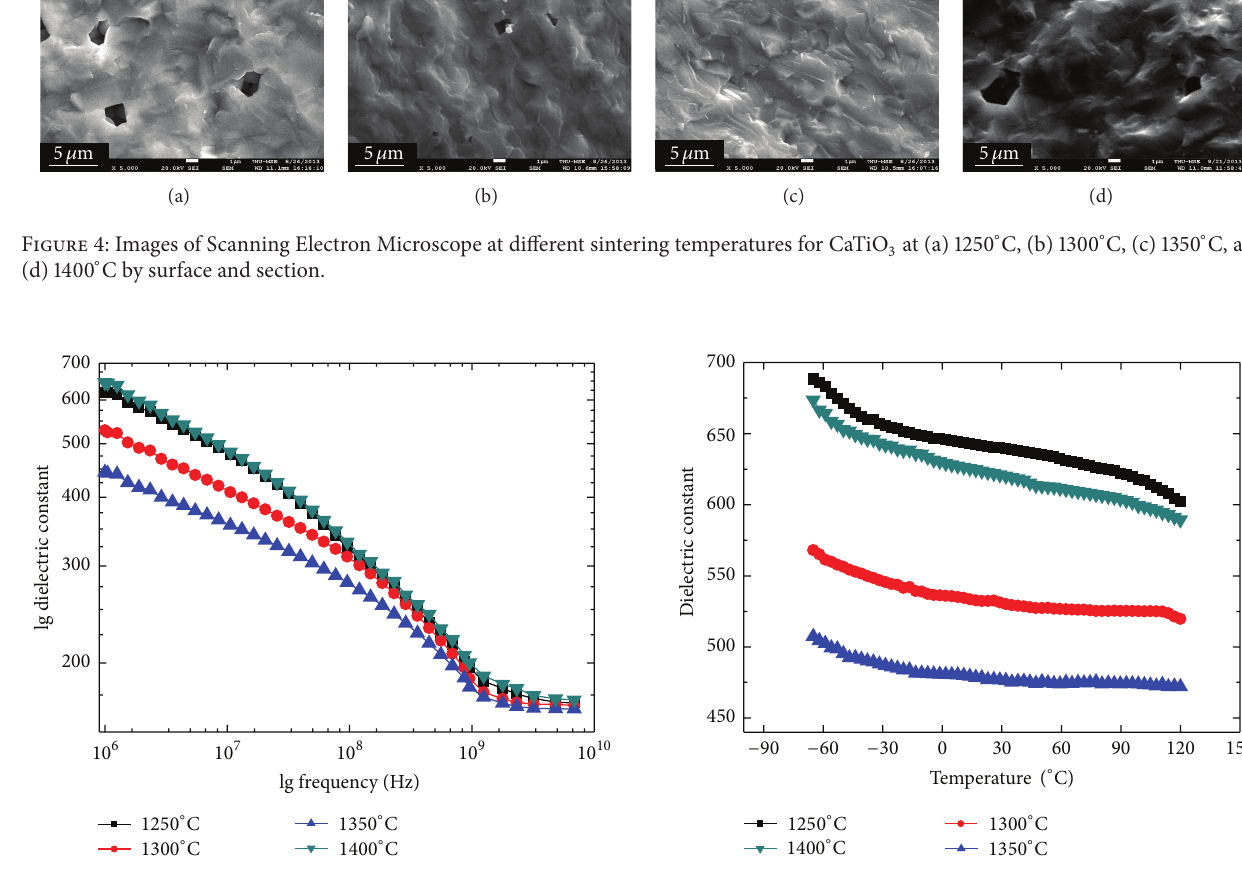
Figure 6: Dielectric constant variation against temperature at 500 kHz for CaTiO 3 , sintered at 1250 ∘ C, 1300 ∘ C, 1350 ∘ C, and 1400 ∘ C,